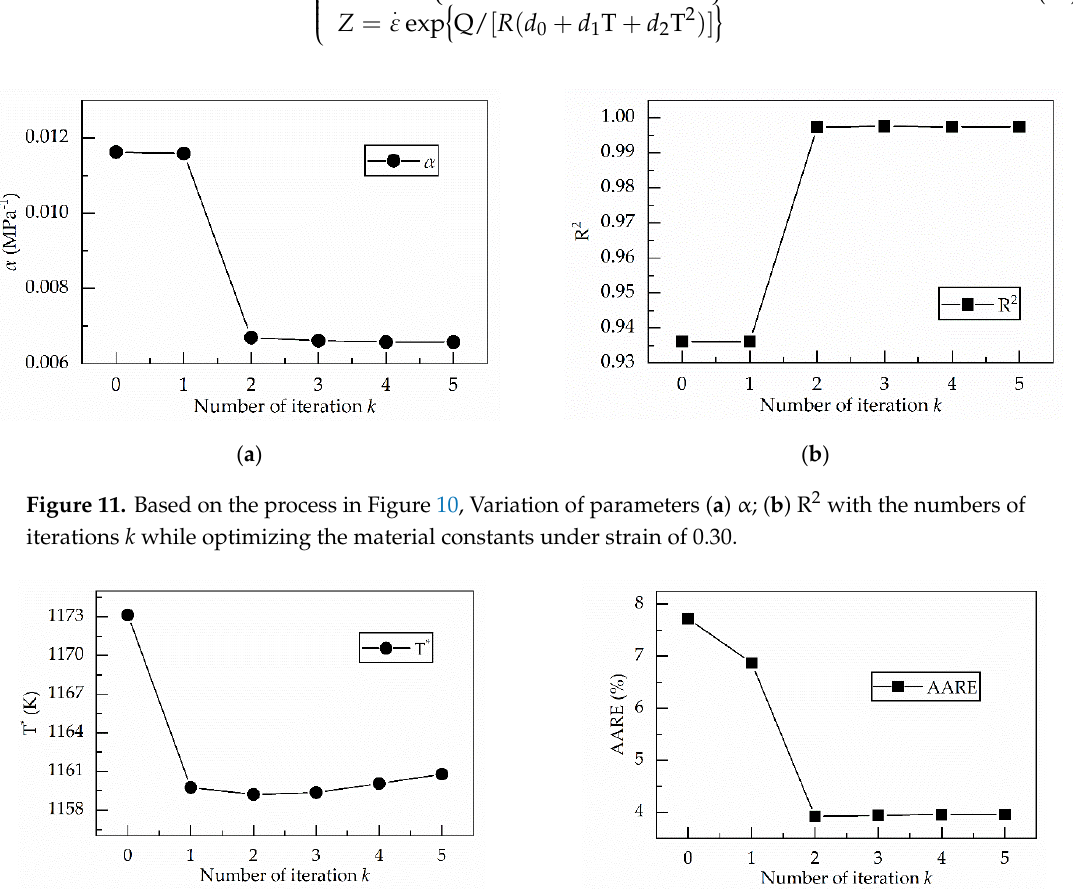
Figure 12. Based on the process in Figure 10, the variation of parameters ( a ) T * ; ( b ) AARE with the numbers of iterations k while optimizing the equivalent temperature under the deformation temperature of 1173.15 K.